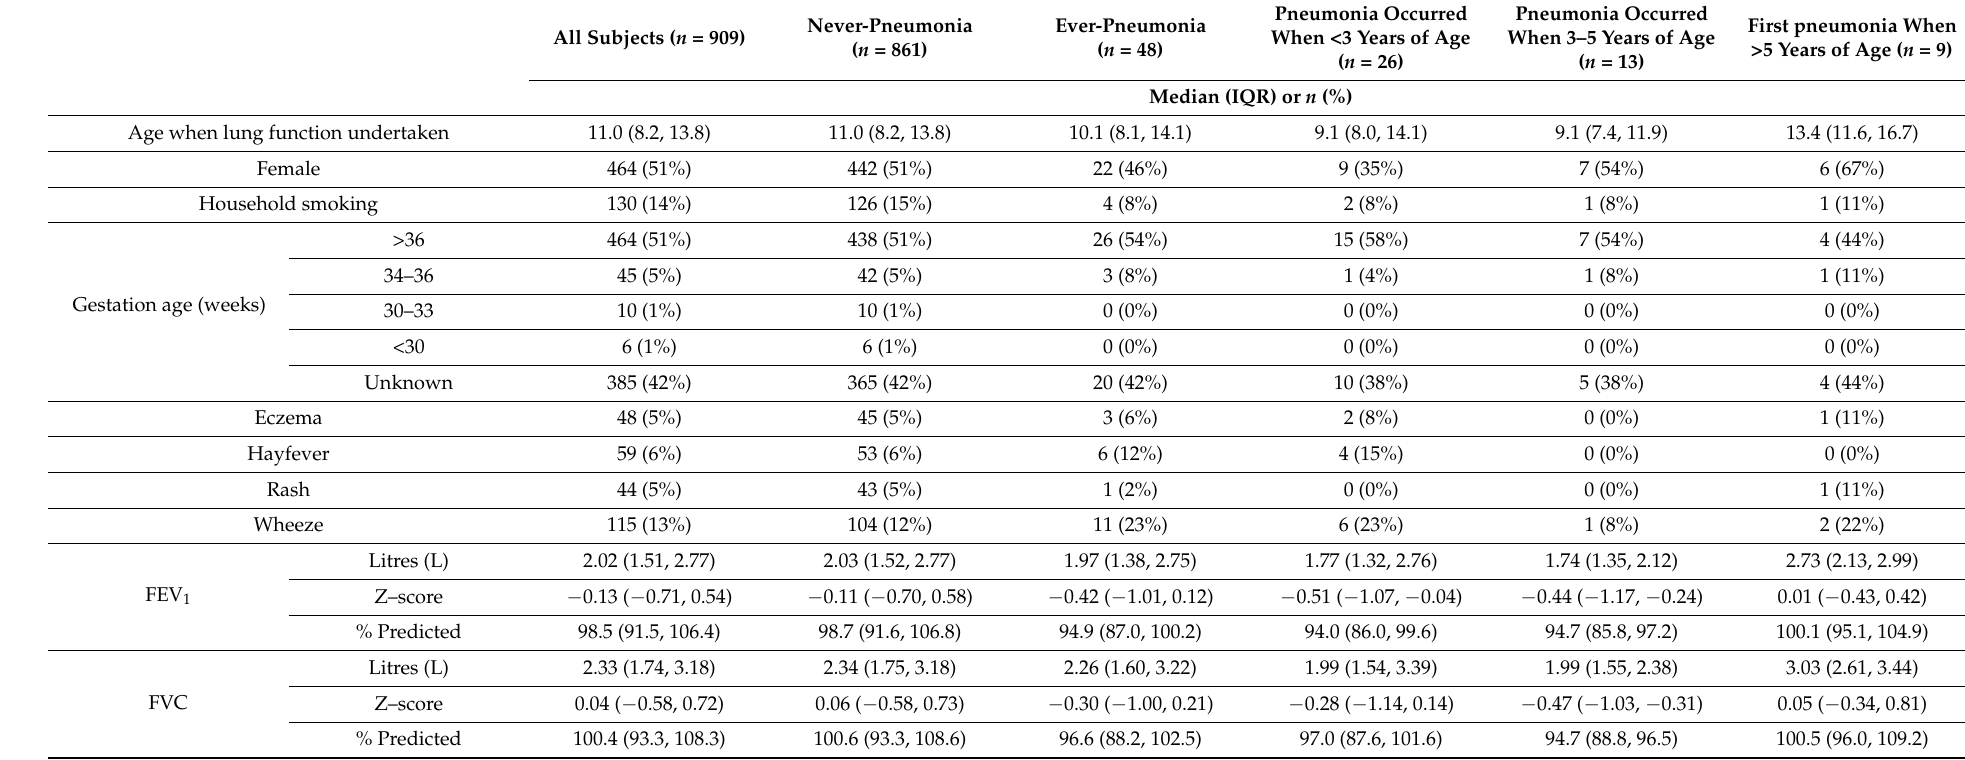
Table 1. Summary of demographics and lung function at the time of lung function testing for 909 First Nations subjects, including 48 subjects with ever-pneumonia status during critical development